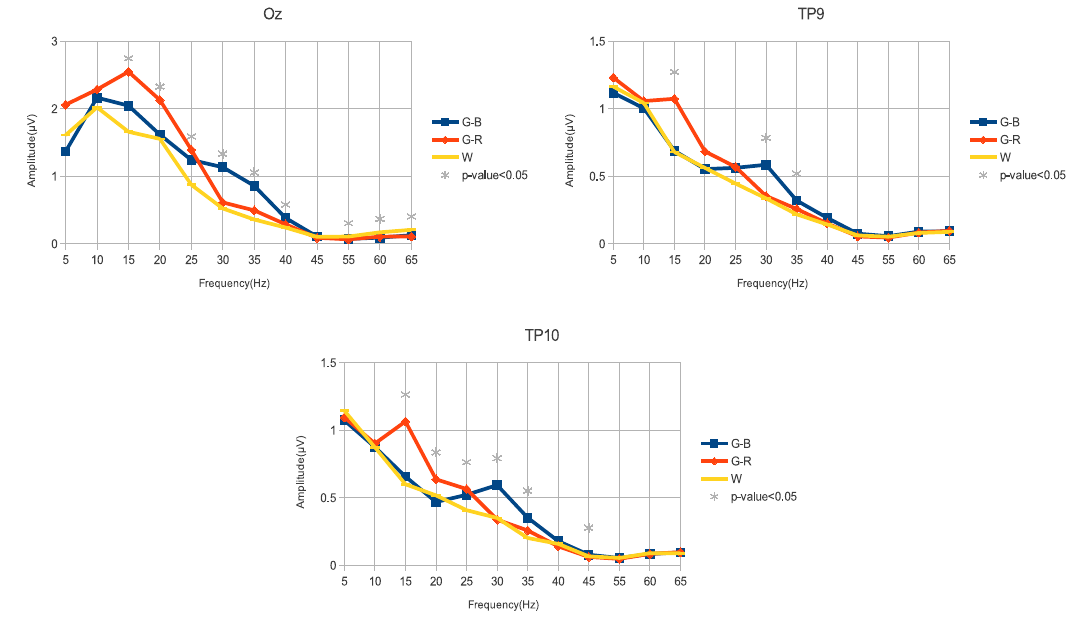
Figure 4. Average of the steady-state visual evoked potential (SSVEP) amplitudes of all volunteers for the Oz, TP9, and TP10 channels using three different stimuli. The frequencies with statistical significance ( p -value < 0.05) based on the Friedman test are marked with an